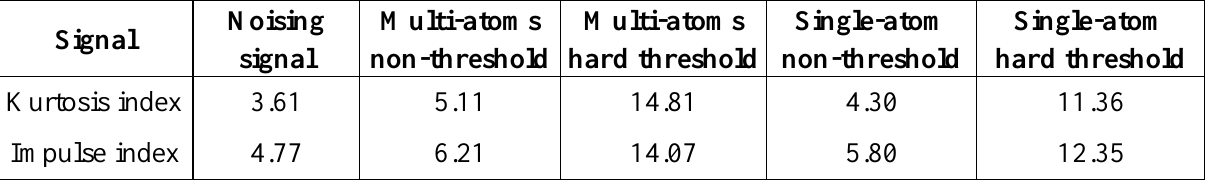
Table 1. Comparison results of kurtosis indices and impulse indices.